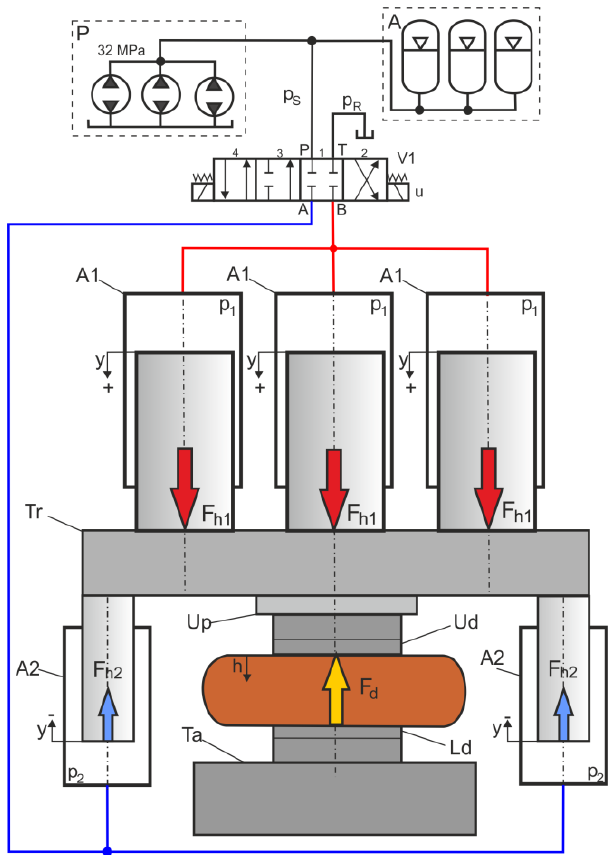
Figure 7. Diagram of the 80 MN hydraulic forging press: A1—main (working) cylinder, A2, A3—return cylinders, V1—4/4/ directional control valve, P—water pump station, A—high-pressure water accumulators, Tr—moving upper beam (traverse), Ud—upper die, Ld—lower die, Up—upper plate for fixing the upper die, Ta—table for fixing the lower die.